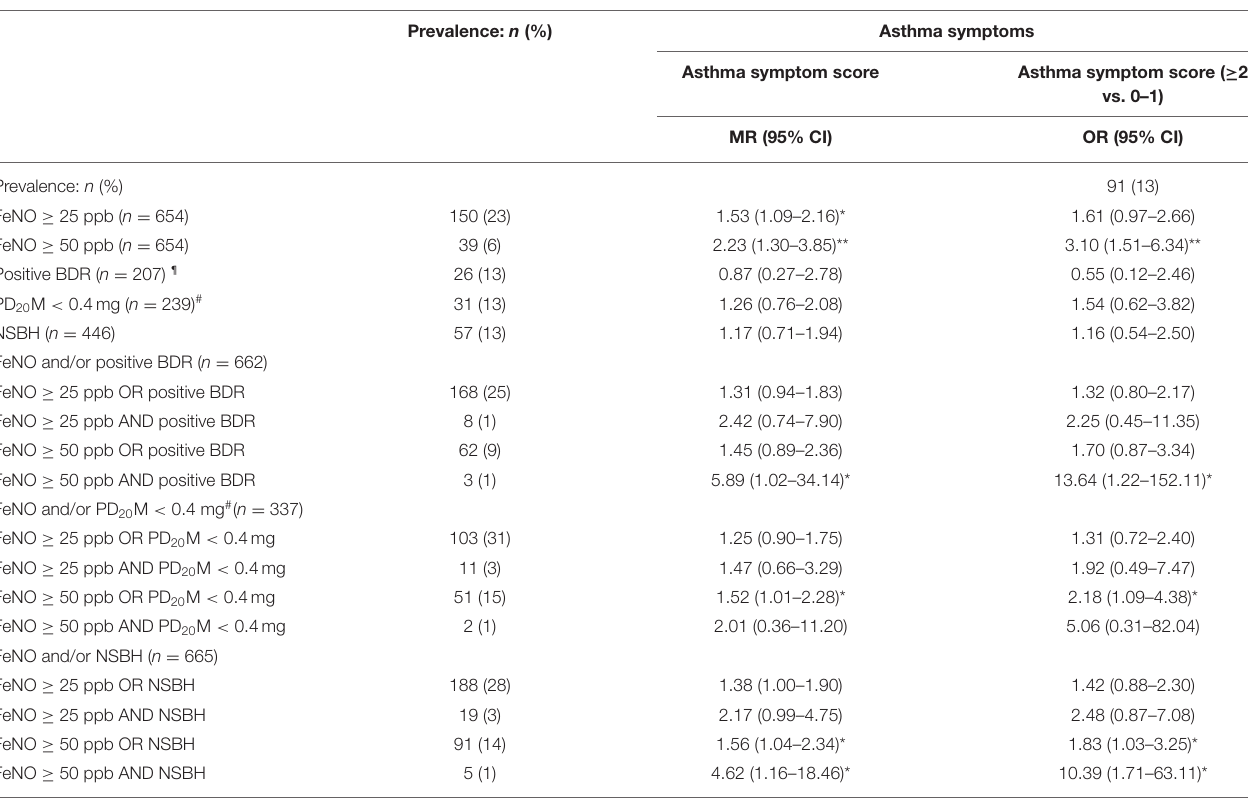
TABLE 3 | Association between FeNO and/or bronchial hyperresponsiveness and asthma symptoms in health workers working with cleaning